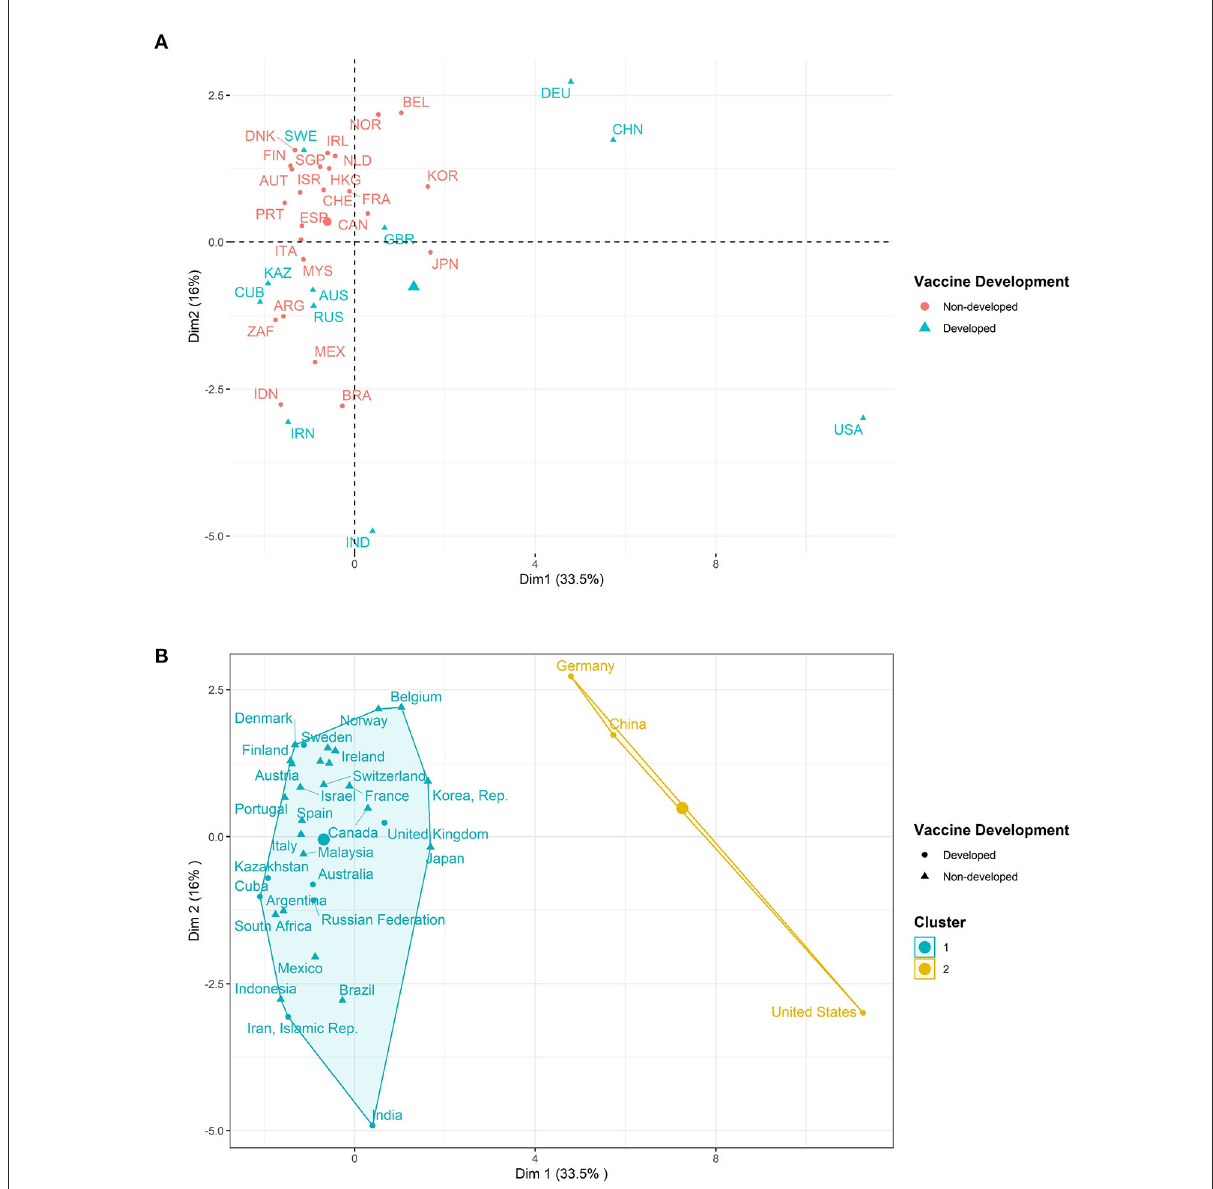
FIGURE1 Unsupervised clustering methods. (A) Principal component analysis. (B) K-means